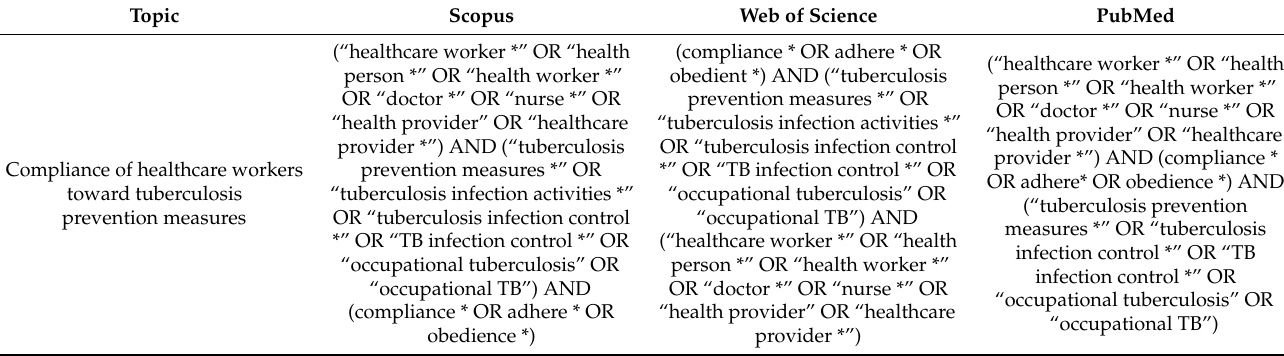
*—symbols in table two refer to a search technique that we used in searching comprehensive keywords for this review. Another useful search technique is called truncation-a feature which allows you to replace one or more letters in a word with a symbol, usually an asterisk (e.g., farm *). Truncation broadens your search, allowing you to easily search for many words at